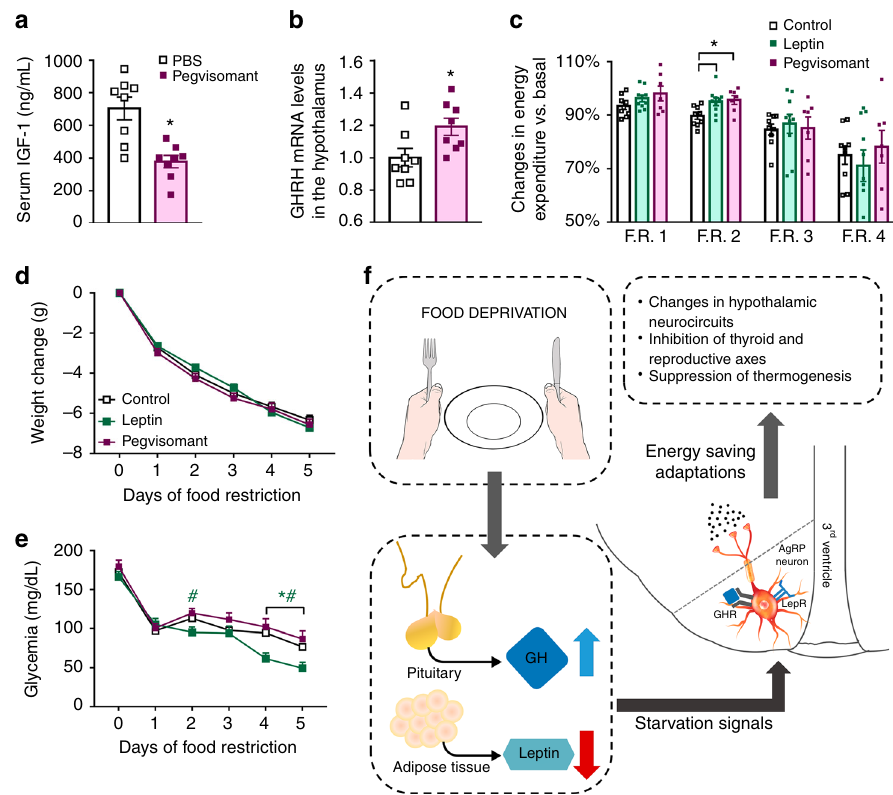
Fig. 7 Pegvisomant produces energy-saving adaptations in food-deprived mice. a Serum insulin-like growth factor-1 (IGF-1) concentration ( t (14) = 4.089, P = 0.0011; n = 8). b Hypothalamic growth hormone-releasing hormone (GHRH mRNA levels ( t = 2.452, P = 0.0279; n = 8). c Energy expenditure (14) (food restriction (F.R.) 1, F (2,23) = 1.83, P = 0.1829; F.R. 2, F (2,23) = 5.396, P = 0.012; F.R. 3, F (2,23) = 0.1271, P = 0.8813; F.R. 4, F (2,23) = 0.4397, P = 0.6496; n = 7 – 10). d Body weight changes (main effect of F.R. [ F (5,125) = 1031, P < 0.0001], main effect of treatment [ F (2,25) = 0.3717, P =